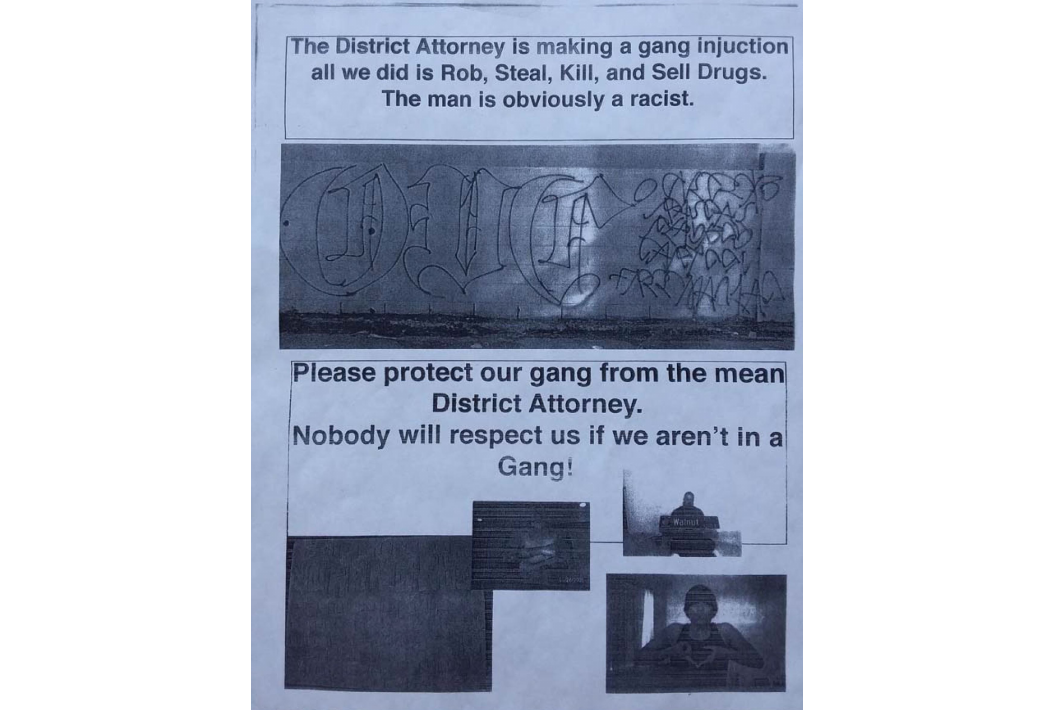
Figure 4. Anonymous flyer distributed to homes in the City of Orange during the fight against the OVC injunction. CU believed it was distributed by police because of its apparent use of police evidence photos produced in the field (Source: James O’Neil